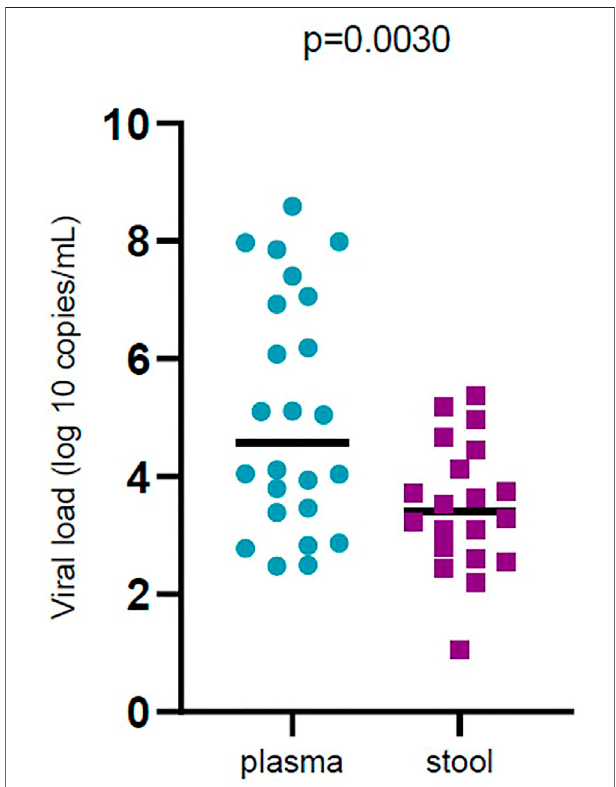
FIGURE 1 | Comparison of severe acute respiratory syndrome coronavirus 2 (SARS -CoV-2) viral load by sample types (plasma and stool). Black bars represent